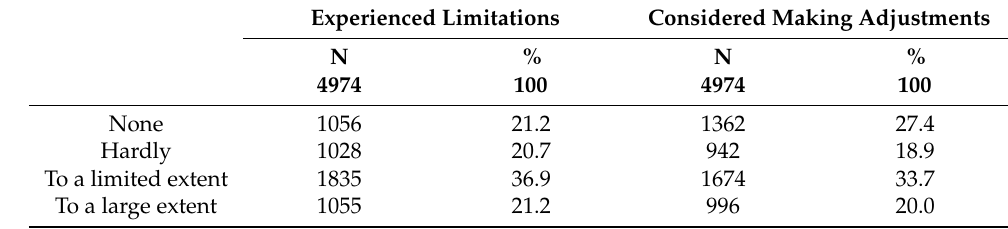
Table 3. Experienced limitations to the practice infrastructure and considered making adjustments to the infrastructure as an effect of the COVID-19 pandemic.